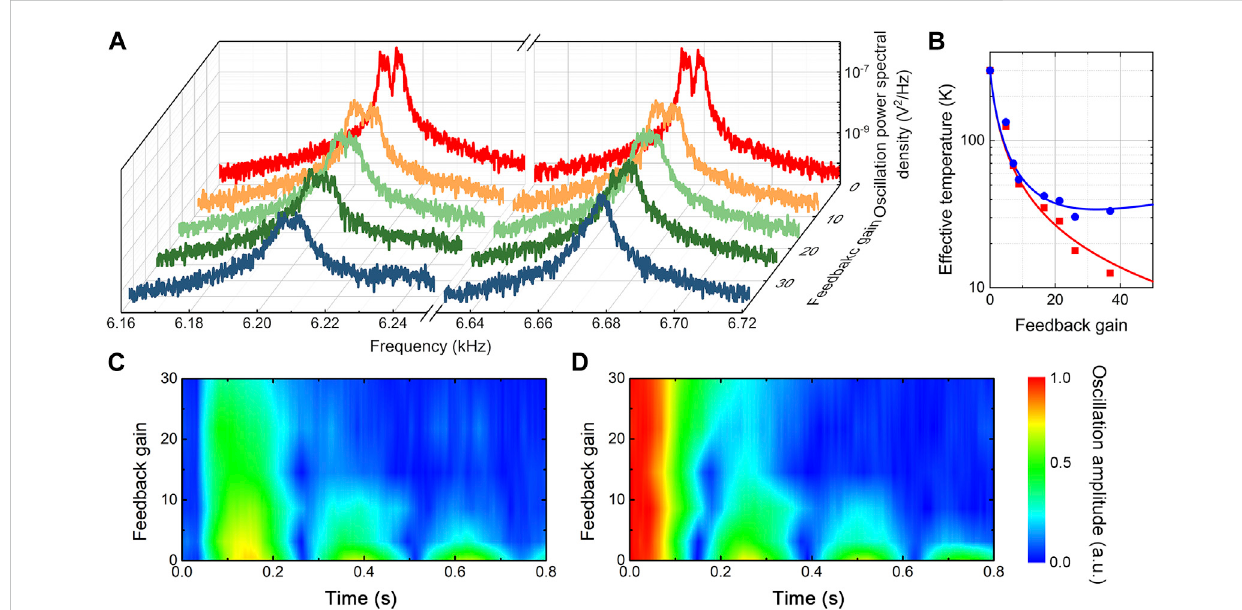
FIGURE 2 (A) Thermal oscillation power spectral density of the modes cooled sympathetically at different feedback gains. The spectra for different feedback gainsarerecordedatthepumppowerof P d (cid:1) 0 . 31mW. Inthecaseof g (cid:1) 0,theparametricpumpcreatesanormal-modesplittingof4.6Hz. (B) Effective temperature of the modes cooled sympathetically under different feedback gains. The effective temperatures of the symmetric mode (red rectangles) andanti-symmetricmode(blue dots)aremeasuredexperimentallybyintegratingthecorrespondingspectrumin (A) arounditsresonant frequency. Also,thetheoreticalresultsforthesymmetricmode(redline)andanti-symmetricmode(blueline)calculatedatthesameconditionofourexperimentare plotted for comparison. (C, D) Oscillation amplitudes of the symmetric and anti-symmetric modes. The anti-symmetric mode is actuated using the radiation pressure force. Also, the real-time oscillation amplitude is measured experimentally by demodulating the motion signal at the resonant frequencies of the corresponding mode with the bandwidth of 60